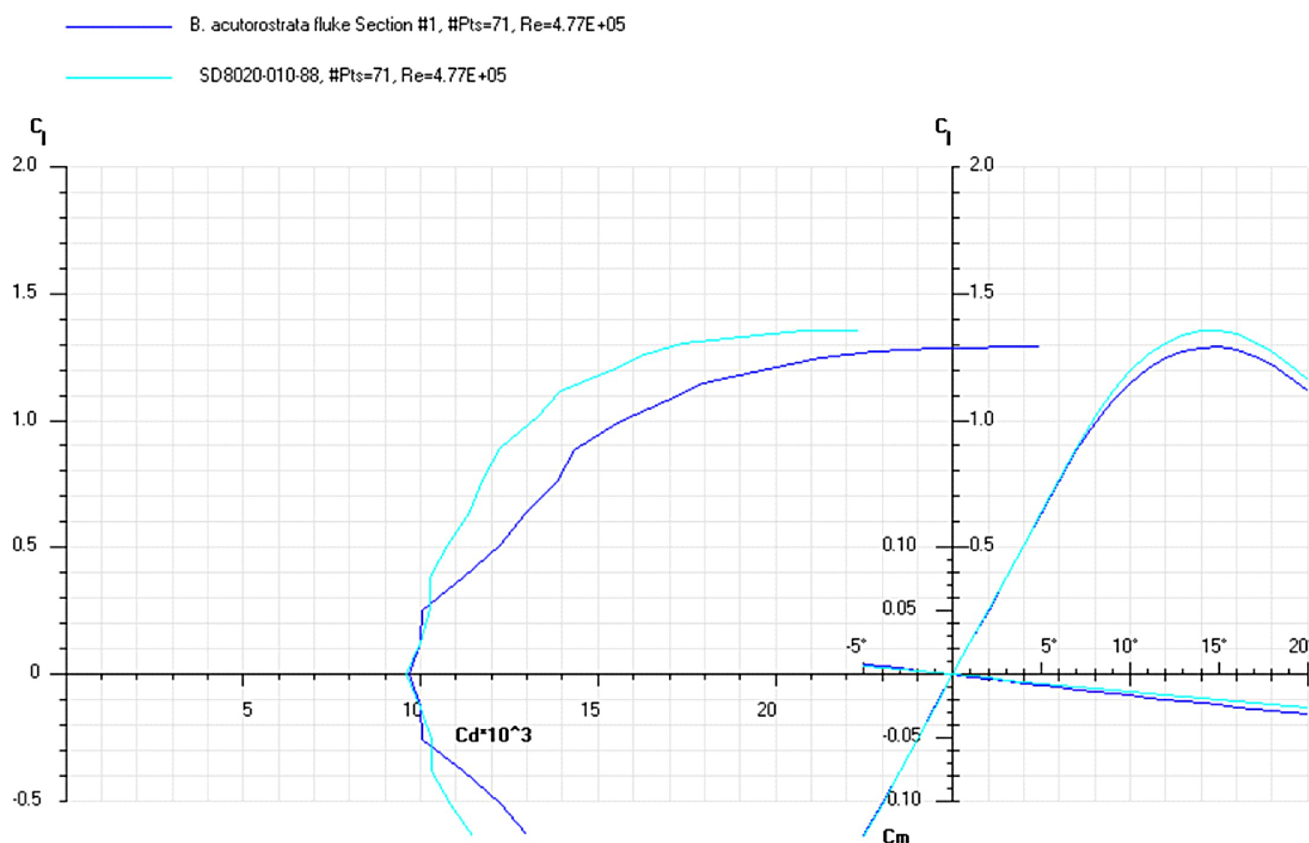
Fig 17. Drag polar diagram of lift CL vs drag Cd. Calculated for the cross-sections taken at the base of the tail flukes of the B . acutorostrata and SD8020 airfoil at the averaged Re 4.77E+05 for the fluke’s cross-sections (Table 10).